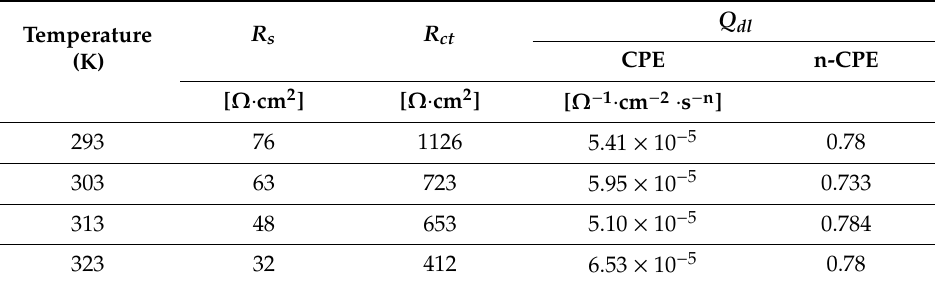
Figure 6. The electrochemical equivalent circuit used to fit EIS data for API-X120 steel in GTL process water at OCP with frequency. Table 6. Fitting values to EIS at different temperatures. Table 6. Fitting values to EIS at di ff erent temperatures.